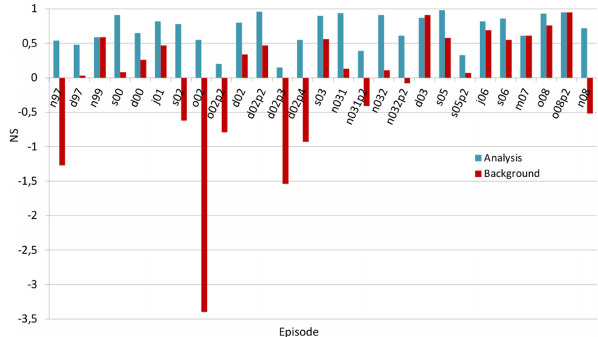
Fig. 9. Comparison of background NS values with NS values fol- lowing data assimilation (analysis). The x-axis contains the episode label in the format mYYpp, where m is the first letter of the month (j is January and m is May), YY is the year and pp is the peak number for the 2nd and greater